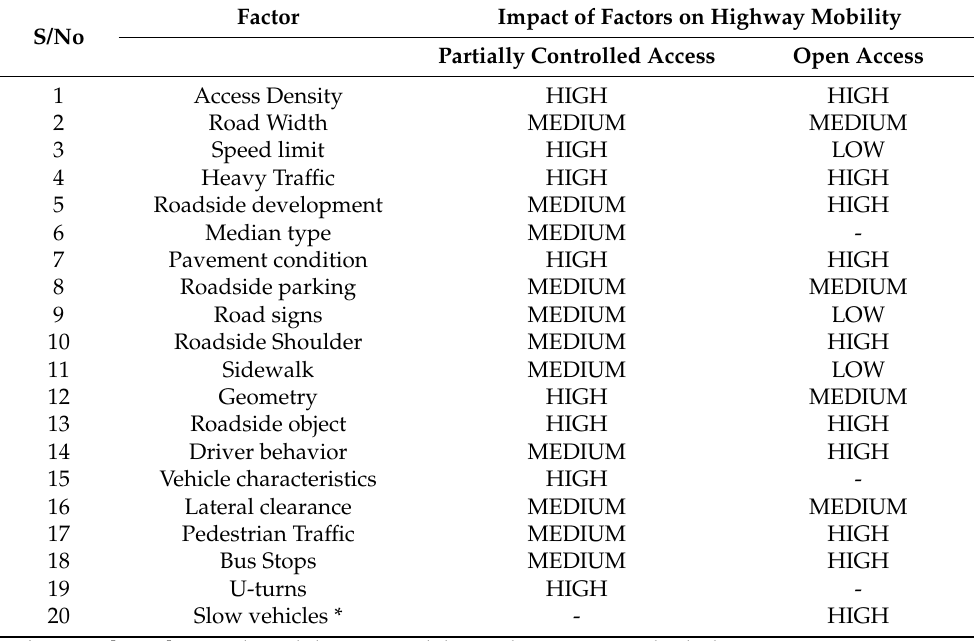
Table 2. Comparison of Mobility Influencing Factors for Different Highway